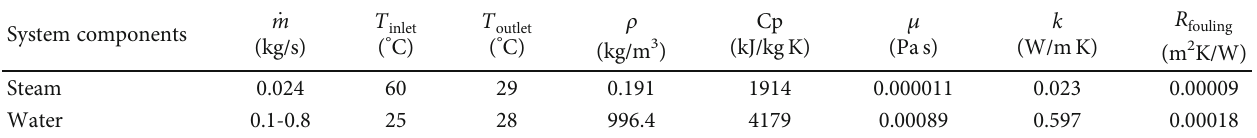
Table 1: Physical parameters of steam and water were taken from the steam evaporator.